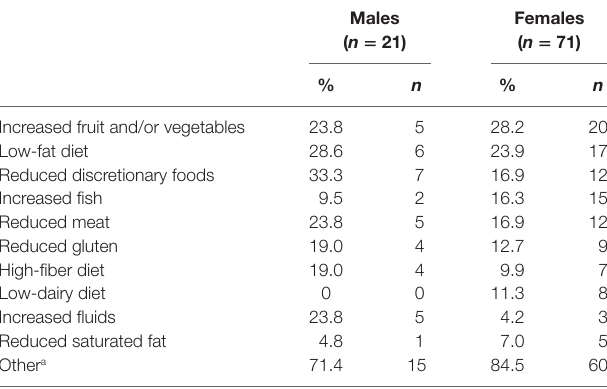
TaBle 4 | Types of dietary changes reported by those participants who made at least one dietary change ( n = 92).